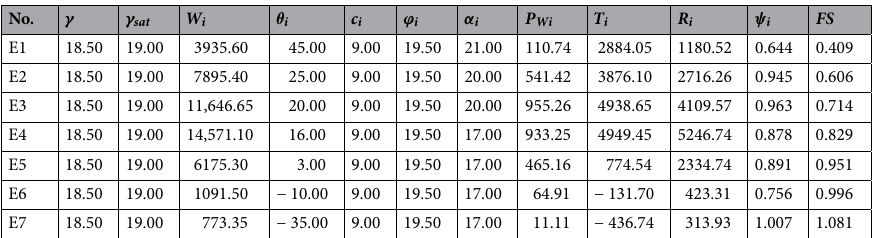
Table 5. Calculation results of the slope stability in cross section 6-6 ′ (without considering rainfall). See “Theoretical calculation” section for the meaning and unit of each parameter.